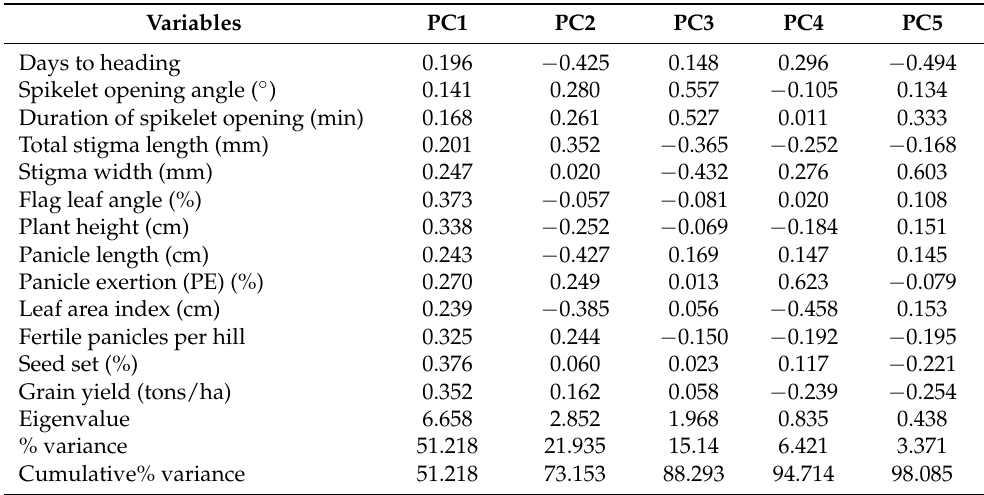
Table 6. Results of principal component analysis (PCs) in the first five PCs for the studied traits during the main effects of experimental